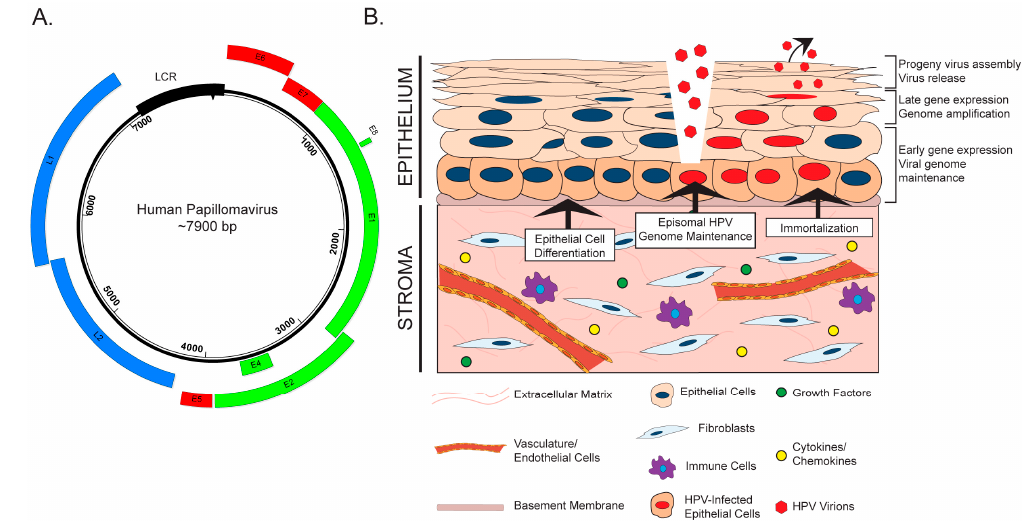
Figure 1. The human papillomavirus (HPV) life cycle and the stroma. ( A ) Map of the HPV genome. Shown is the circular, ~7900 base pair (bp) double-stranded DNA (dsDNA) genome of HPV18. The boxes represent translational open reading frames that encode HPV proteins. Early (E) genes are shown in green and late genes (L) are shown in blue. The long control region (LCR), which regulates transcription and viral DNA replication, is shown by a black box. Three HPV oncogenes, E5, E6, and E7, are shown in red. ( B ) A schematic representation of the stratified epithelium, underlying stroma, and the HPV life cycle is shown. Basal cells, which are adjacent to the basement membrane and underlying stroma, are shown in dark tan. HPV virions infect the basal cells of the stratified epithelium, presumably through a break or wound in the epithelial layer. The virus life cycle proceeds throughout the epithelium and is tied to differentiation, ending with progeny virus production and release from the terminally differentiated cells. Labels indicating the spatiotemporal regulation of key events in the HPV life cycle are shown to the right of the stratified epithelium. The stroma, which is composed of various cell types, vasculature, and connective tissue, has been shown to promote epithelial cell immortalization, maintenance of episomal HPV genomes, and epithelial cell differentiation in support of the HPV life cycle (indicated by black arrows). Please refer to the legend to identify common components of the stroma, and to the text for further detail.